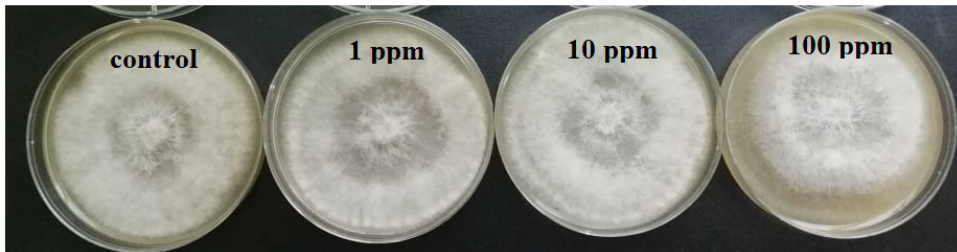
Figure 6. Effect of different Cu NP concentrations on the growth of B. cinerea at 9 days of age: control and treatments with Cu NPs of 0 (as control) 1, 10, and 100 ppm concentrations, agar dilution